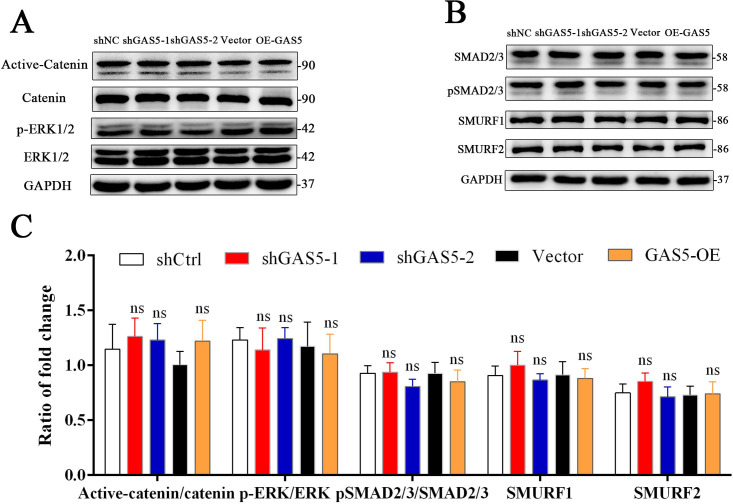
Western blot analysis of the pathway.(A, B) Western blot analysis and quantification of the pathway (catenin, ERK, SMAD2/3, SMURF1, SMURF2) in GAS5 knockdown or overexpression conditions. (C) Quantification for western blot analysis of β-catenin, ERK, SMAD2/3, SMURF1, and SMURF2.